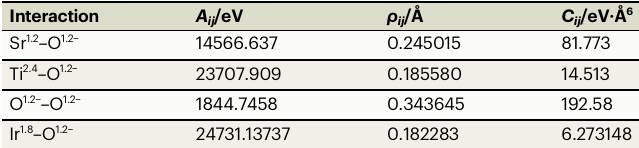
Table 1 | Buckingham pair potentials used for pair potential- based simulations